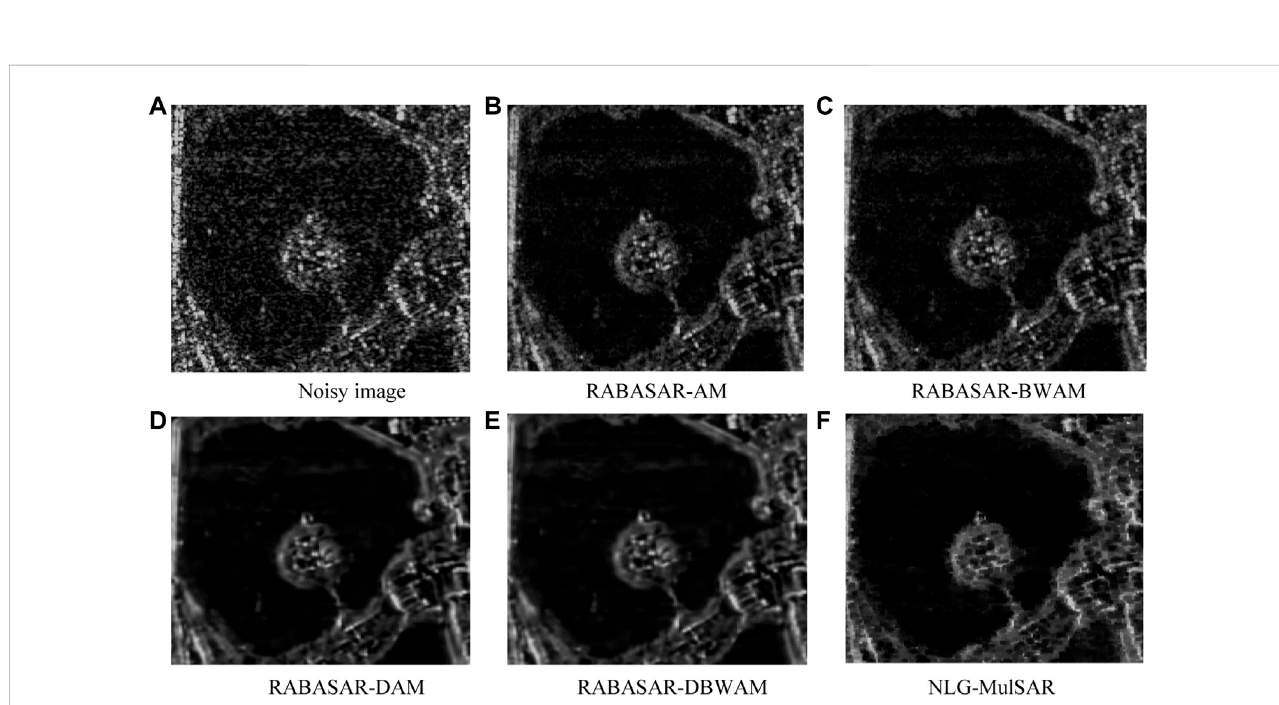
FIGURE 7 Comparison of results obtained using different algorithms (A) Noisy image, (B) RABASAR-AM, (C) RABASAR-BWAM, (D) RABASAR-DAM, (E) RABASAR- DBWAM, (F)